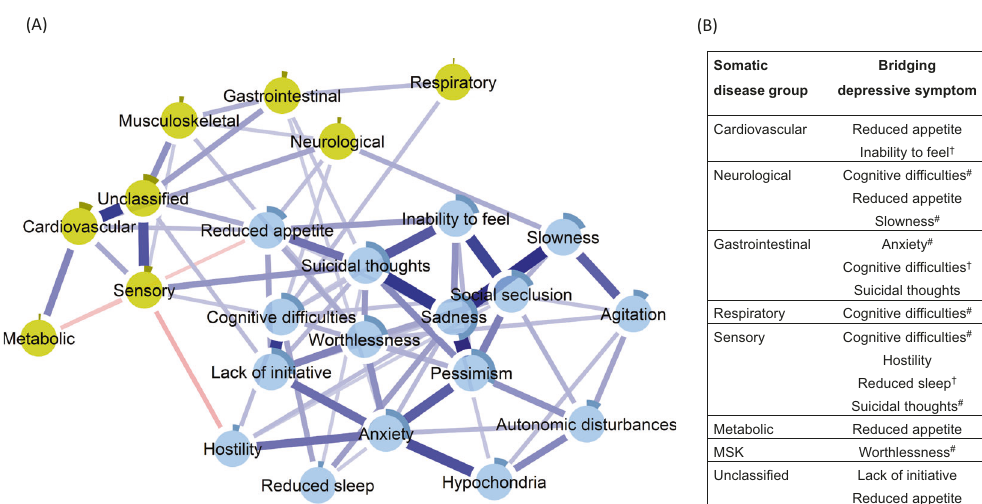
Fig. 2 Network of depressive symptoms with nodes for system-speci fi c clusters of somatic disease burden (panel A ). Blue connections indicate positive correlations; red, negative correlations; thickness of lines is proportional to the strength of the correlation. The darker outer circle of each node represents the predictability, i.e., the proportion of variance explained by its neighbouring nodes. The table (panel B ) reports bridge connections between somatic disease groups and depressive symptoms. # Bridge connection preserved after including nodes for age, sex, and education. † Bridge connection emergent in the network including nodes for age, sex, and education.